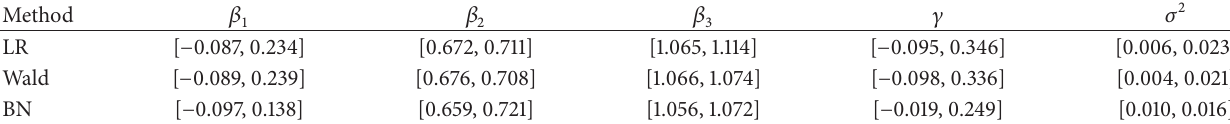
Table 5: Results for 95% confidence intervals for 𝛽 1 , 𝛽 2 , 𝛽 3 , 𝜎 2 , and 𝛾